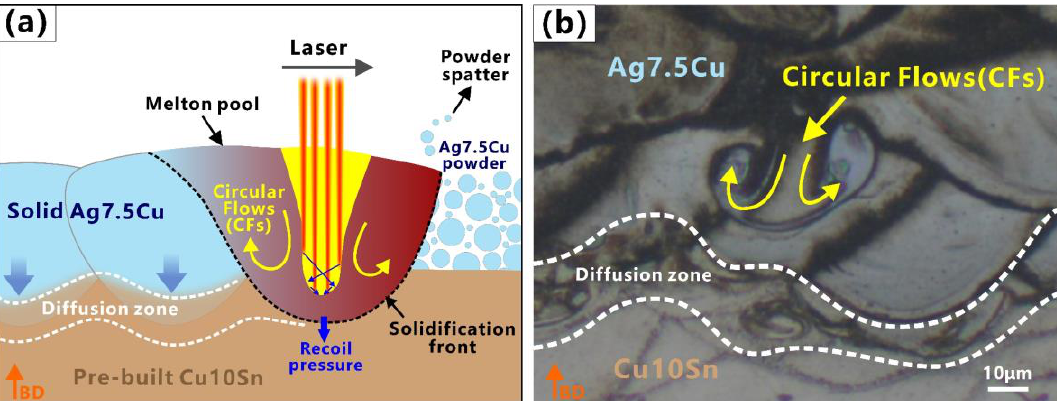
Figure 9. Melting mode of C/A interface in multi-material LPBF: ( a ) schematic illustration of molten pool behavior; ( b ) molten pool morphology at C/A interface. Orange arrows indicate the building direction (BD).